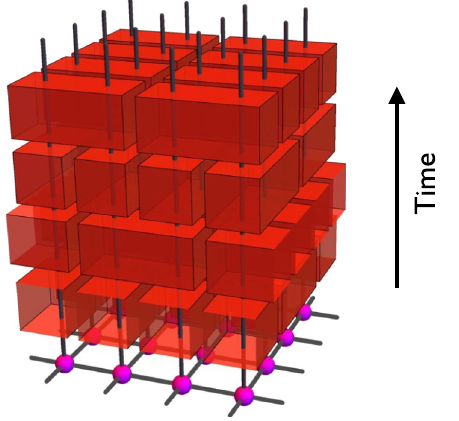
FIG. 5. Geometry of 2 þ 1 D Haar-random circuit.